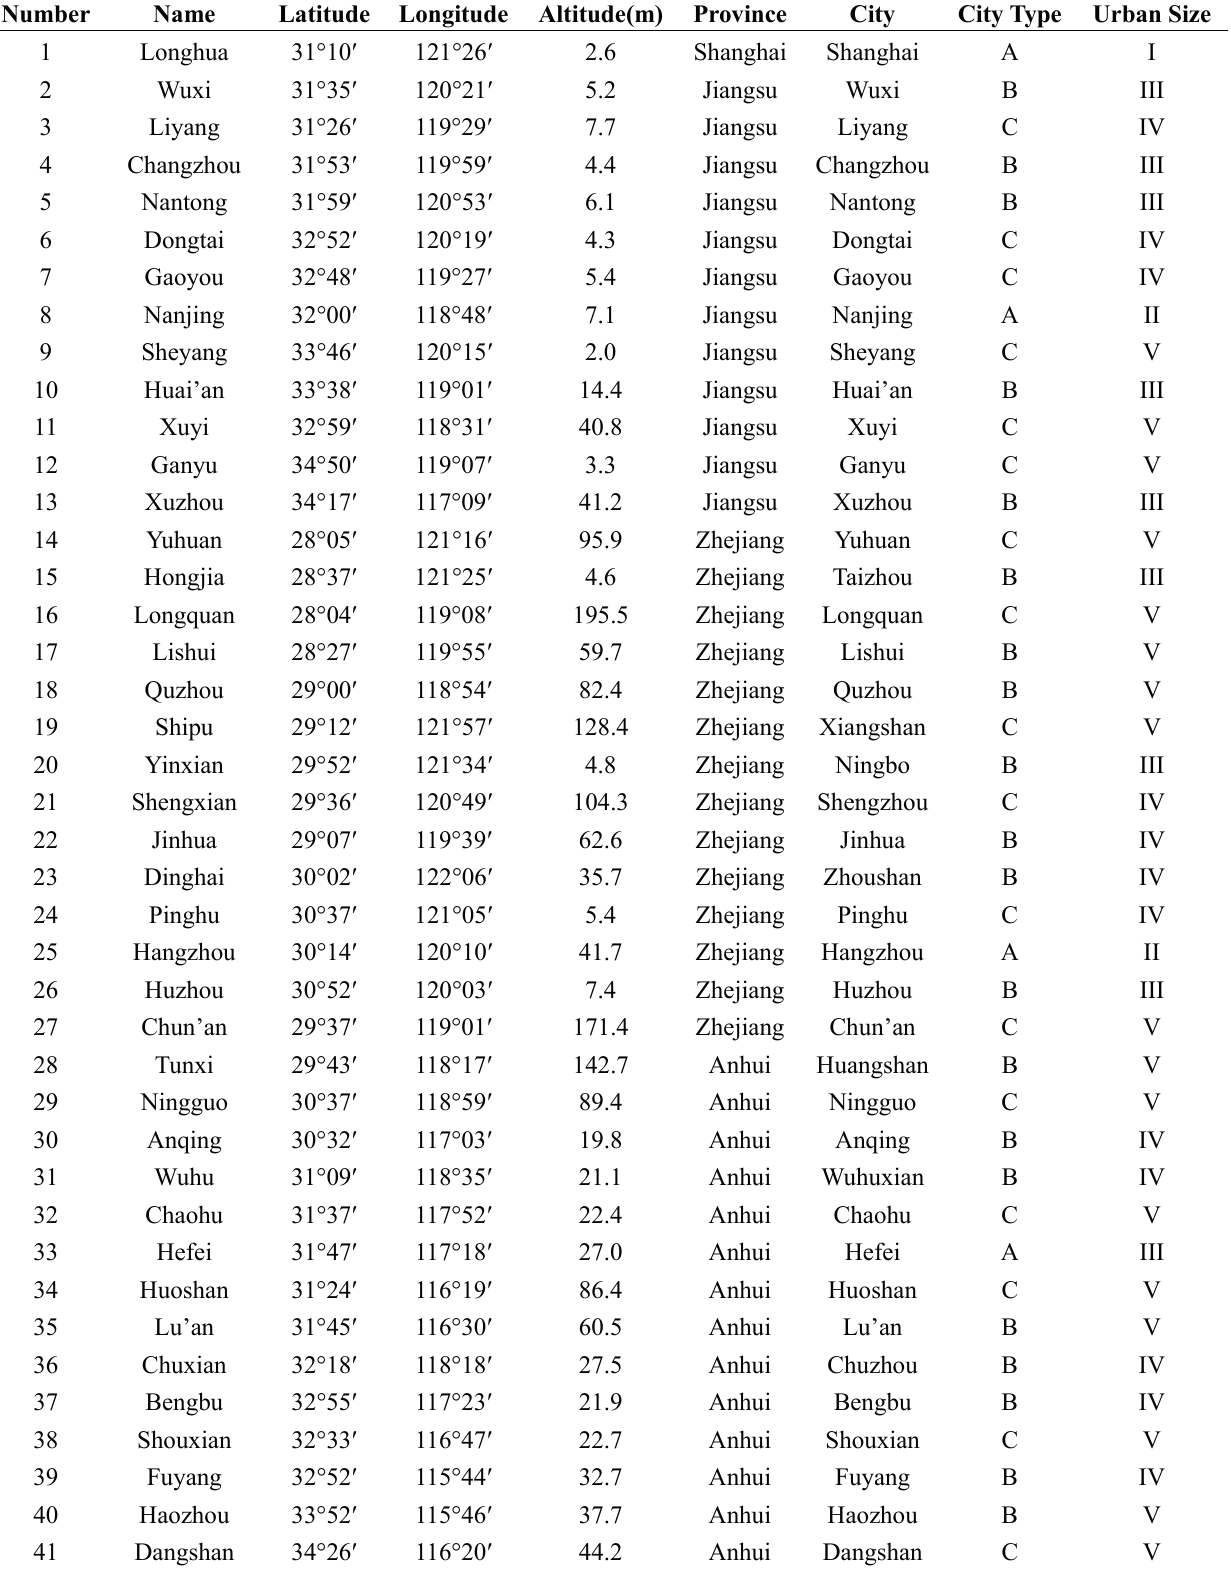
Table 1. Information on 41 meteorological stations in the